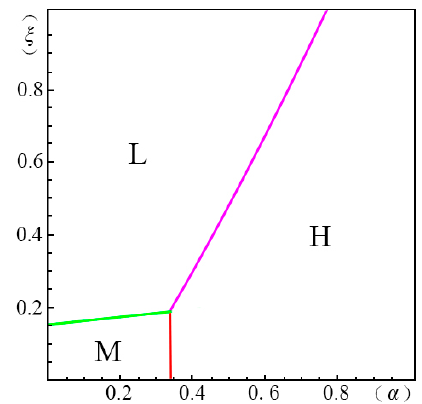
> p 2 A + kg − p (cid:3408) (cid:3043) (cid:3118)(cid:3250) (cid:3397)(cid:1863)(cid:1859) (cid:2879)(cid:3043) . σδ Q − 1 σδ Q ( 1 − λ ) (cid:3097)(cid:3083)(cid:3018)(cid:4666)(cid:2869)(cid:2879)(cid:3090)(cid:4667) (cid:3097)(cid:3083)(cid:3018)(cid:2879)(cid:2869)